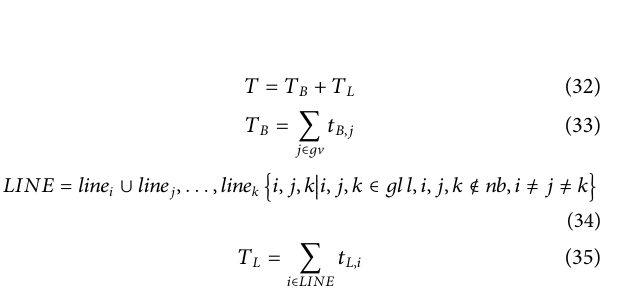
FIGURE 5 Group diagram and partition diagram of subnet Ⅲ .